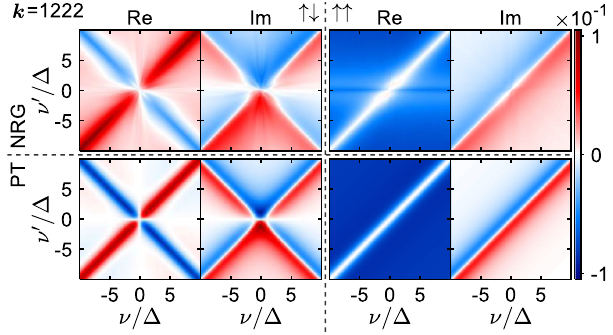
− F k =U at ω ¼ 0 and FIG. 12. KF 4p point vertex ð F k σσ 0; σσ 0 Þ 0 k ¼ 1222 in the AIM at weak interaction, U= Δ ¼ 1 = 2 . The left-hand (right-hand) panels show the real and imaginary parts for σ ≠ σ 0 ( σ ¼ σ 0 ). The top row shows NRG data, with U=D ¼ 1 = 20 and T ¼ 10 − 3 D ; the bottom row shows results of second-order perturbation theory (PT) in the wideband and zero- temperature limit. We find very good qualitative agreement (the overall magnitude depends on the broadening prescription), even though the limit of weak interaction is highly nontrivial for the diagonalization-based